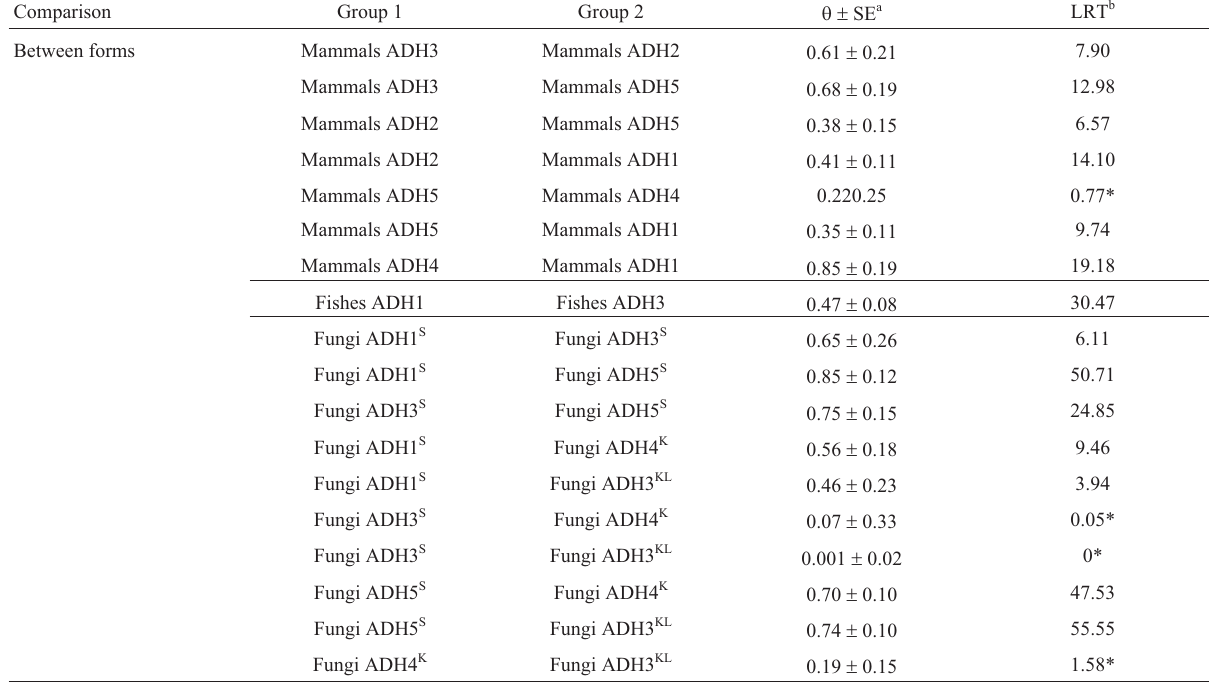
Table 2 - Coefficients of functional divergence ( (cid:6) ) of pairwise comparisons in the alcohol dehydrogenase gene family. Comparison Between